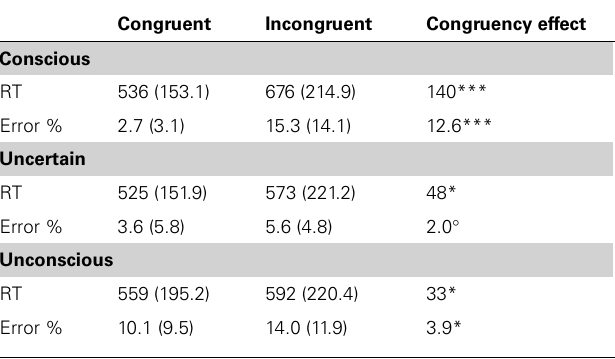
Table 2 | Mean (SD) of the median RTs (in ms) and mean error rates (in %) as a function of condition and congruency and the congruency effects